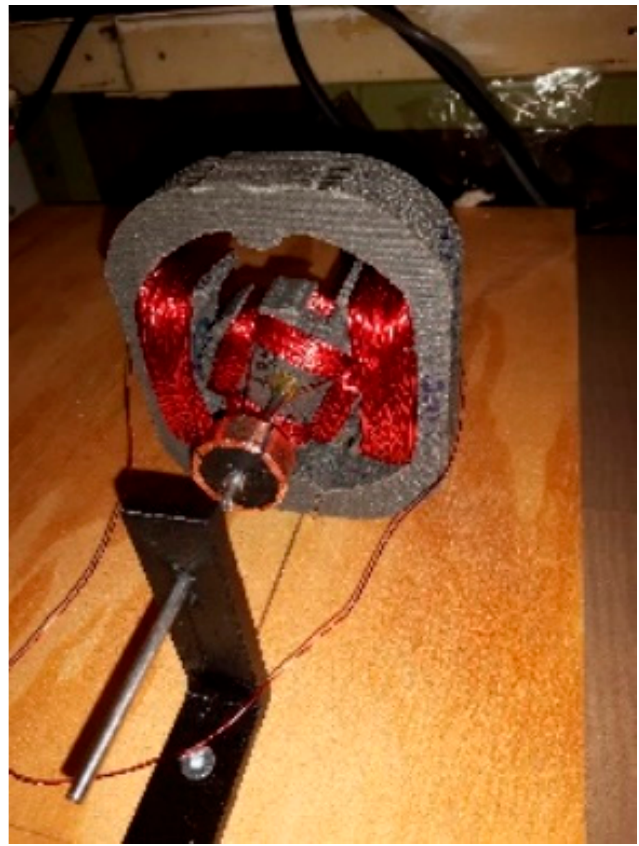
Figure 4. FDM-printed rotor and stator of Fe particles embedded in PLA matrix.